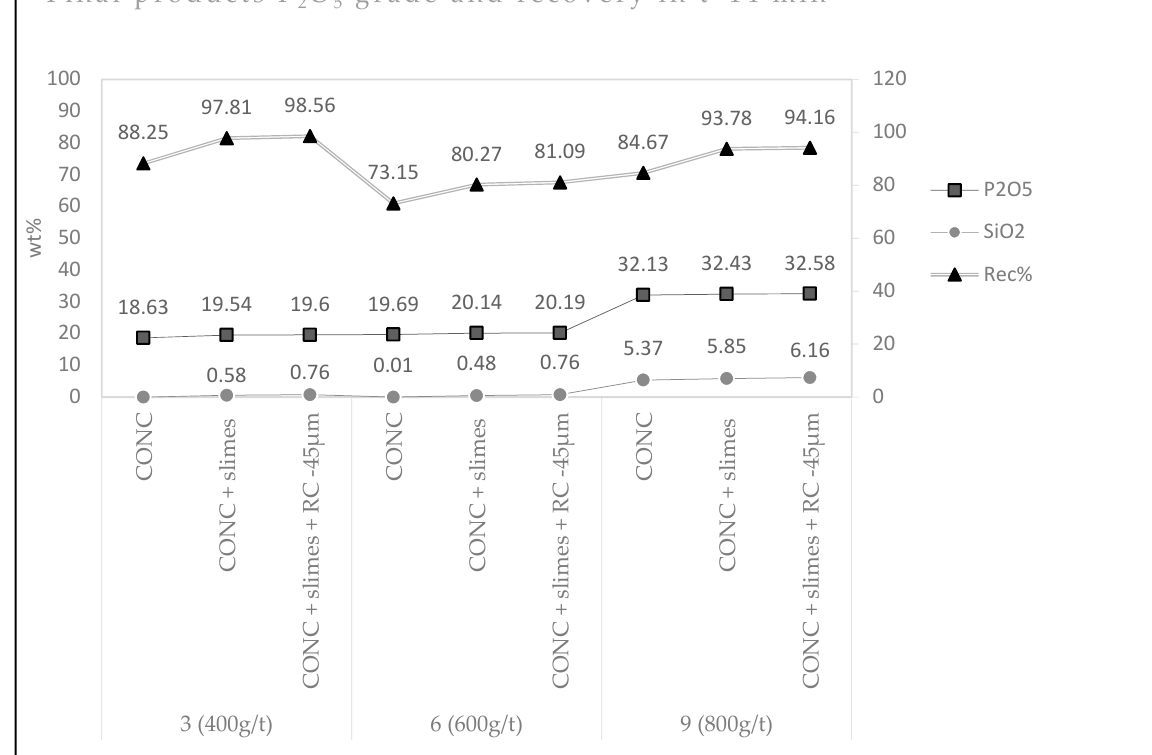
Figure 10. Grades and recovery changes in tests 3, 6, and 9 for the final product. ( t = 14 min).